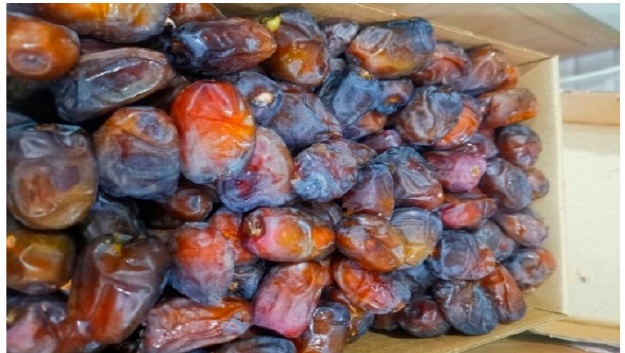
Figure 20. Sample of Al-shagra dates.